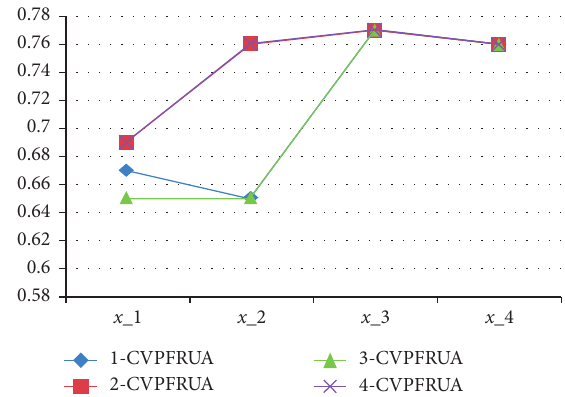
Table 4: The overall upper preference indices among drugs.